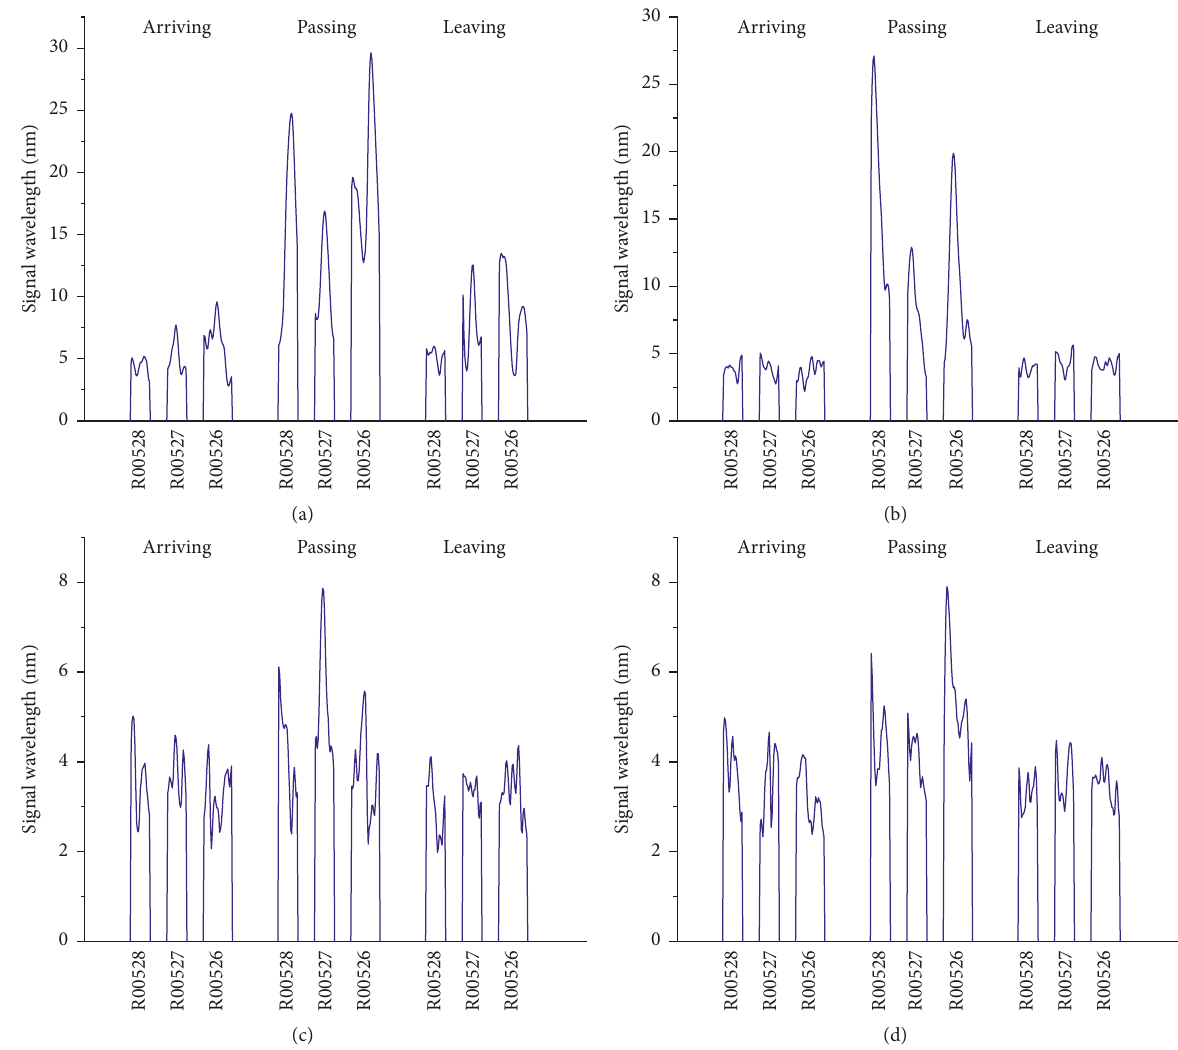
Figure 17: Vibration signal of the left track line after L00526 repair: (a) 1 st train; (b) 2 nd train; (c) 3 rd train; (d) 4 th